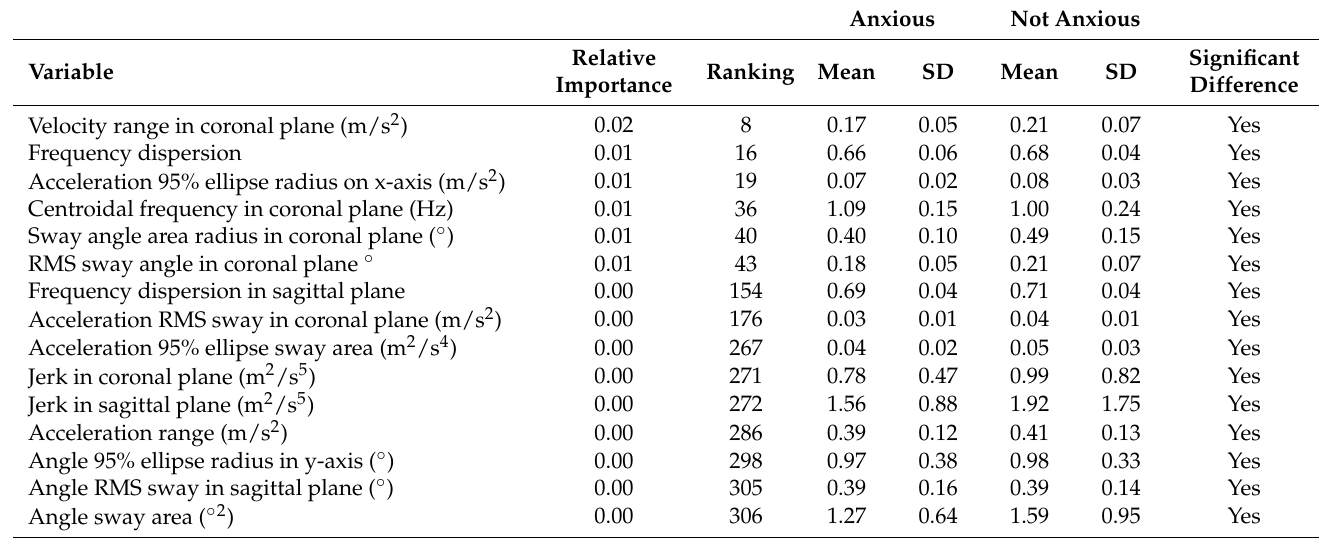
Table 4. Significant Variables Only for Eyes Open, Feet on Foam